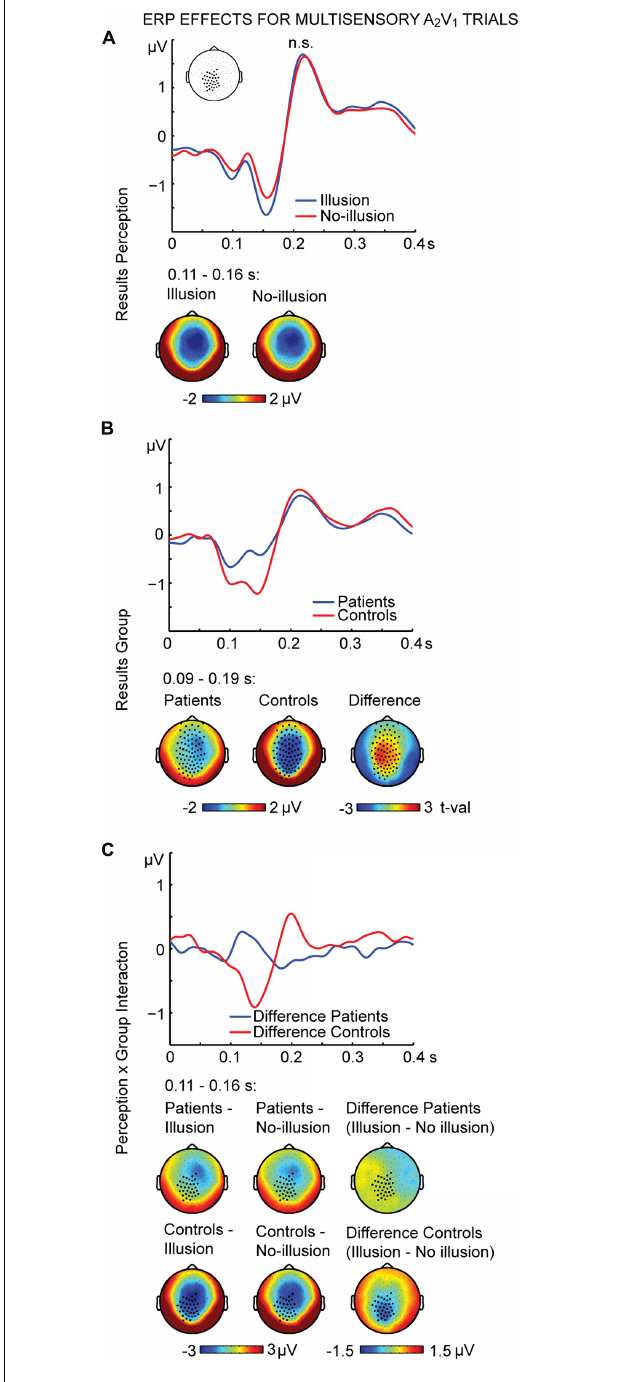
FIGURE 2 | ERP effects of multisensory A 2 V 1 trials. Outcome of the non-parametric tests with cluster-based correction for multiple comparisons between Perceptions (illusion vs. no-illusion), between Groups (SCZ vs. HC), and for the Perception differences between Groups (i.e., the Perception by Group interaction). The upper planes in panels (A–C) illustrate the ERP results for Perception (A) , the main effect of Group (B) , and the Perception by Group interaction (C) . The lower planes depict topographic maps for the observed results with highlighted significant cluster electrodes. Time-point 0 indicates the onset of the first auditory and visual